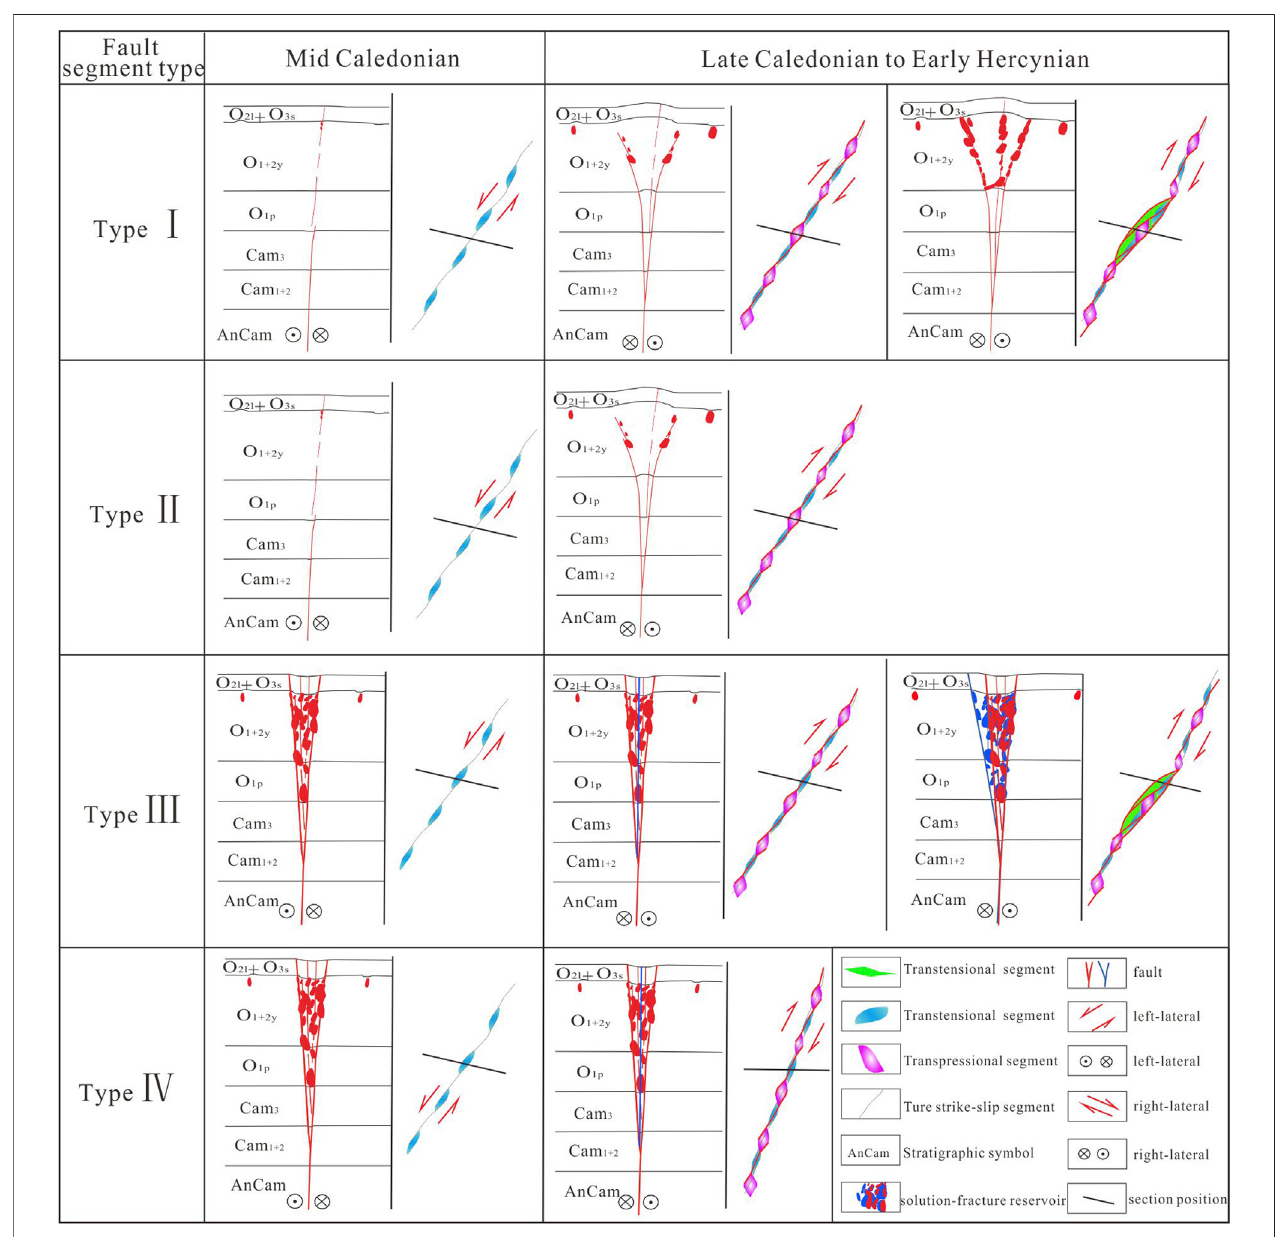
FIGURE 8 | Segment-type diagram of a NE-trending strike-slip fault based on the evolution characteristics.